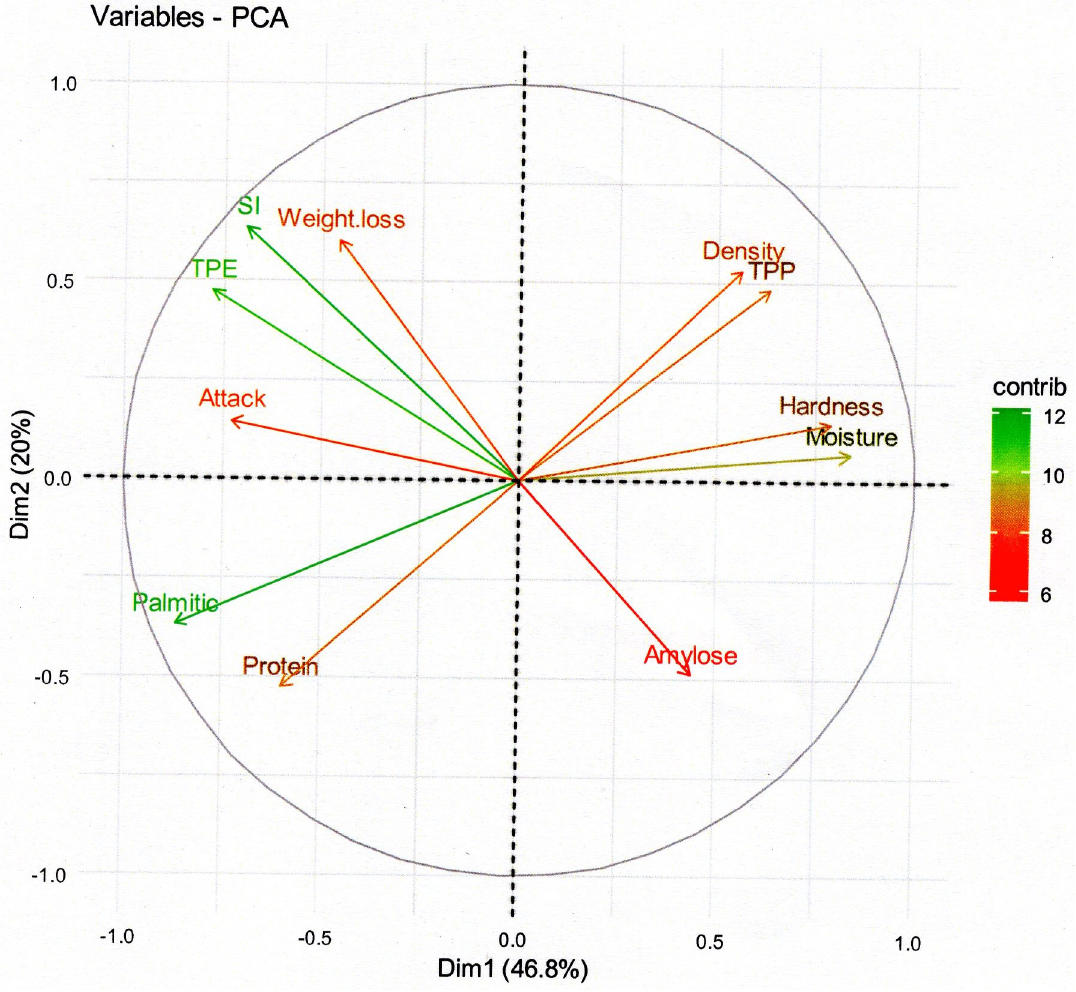
Fig 2. Eigenvalue diagram on PCA of maize susceptibility parameters. Eigenvalue diagram on Principal Component Analyses (PCA) of maize susceptibility parameters. The significance level for the contribution of the Principal Components (PC) is indicated by a color gradient. The annotation is TPE : Total Progeny Emerged, SI : Susceptibility Index, Attack : Attack percent of maize grains (damage percent), Weight loss : Weight loss percent of maize grains, Moisture : Percentage of grains moisture, TPP : Total Phenolics Content, Palmitic : Percentage of palmitic in grain fatty acids, Protein : Percentage of proteins in grain, Amylose : Percentage of amylose in grain starch, Density : Maize grains density, Hardness : Maize grains hardness.